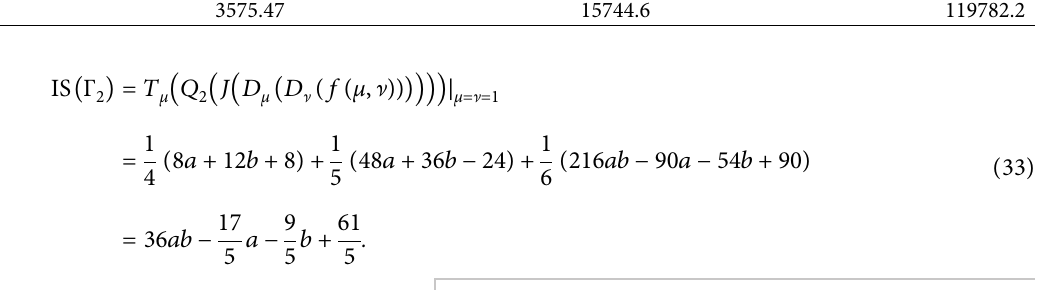
Table 8: Comparison between H ( Γ